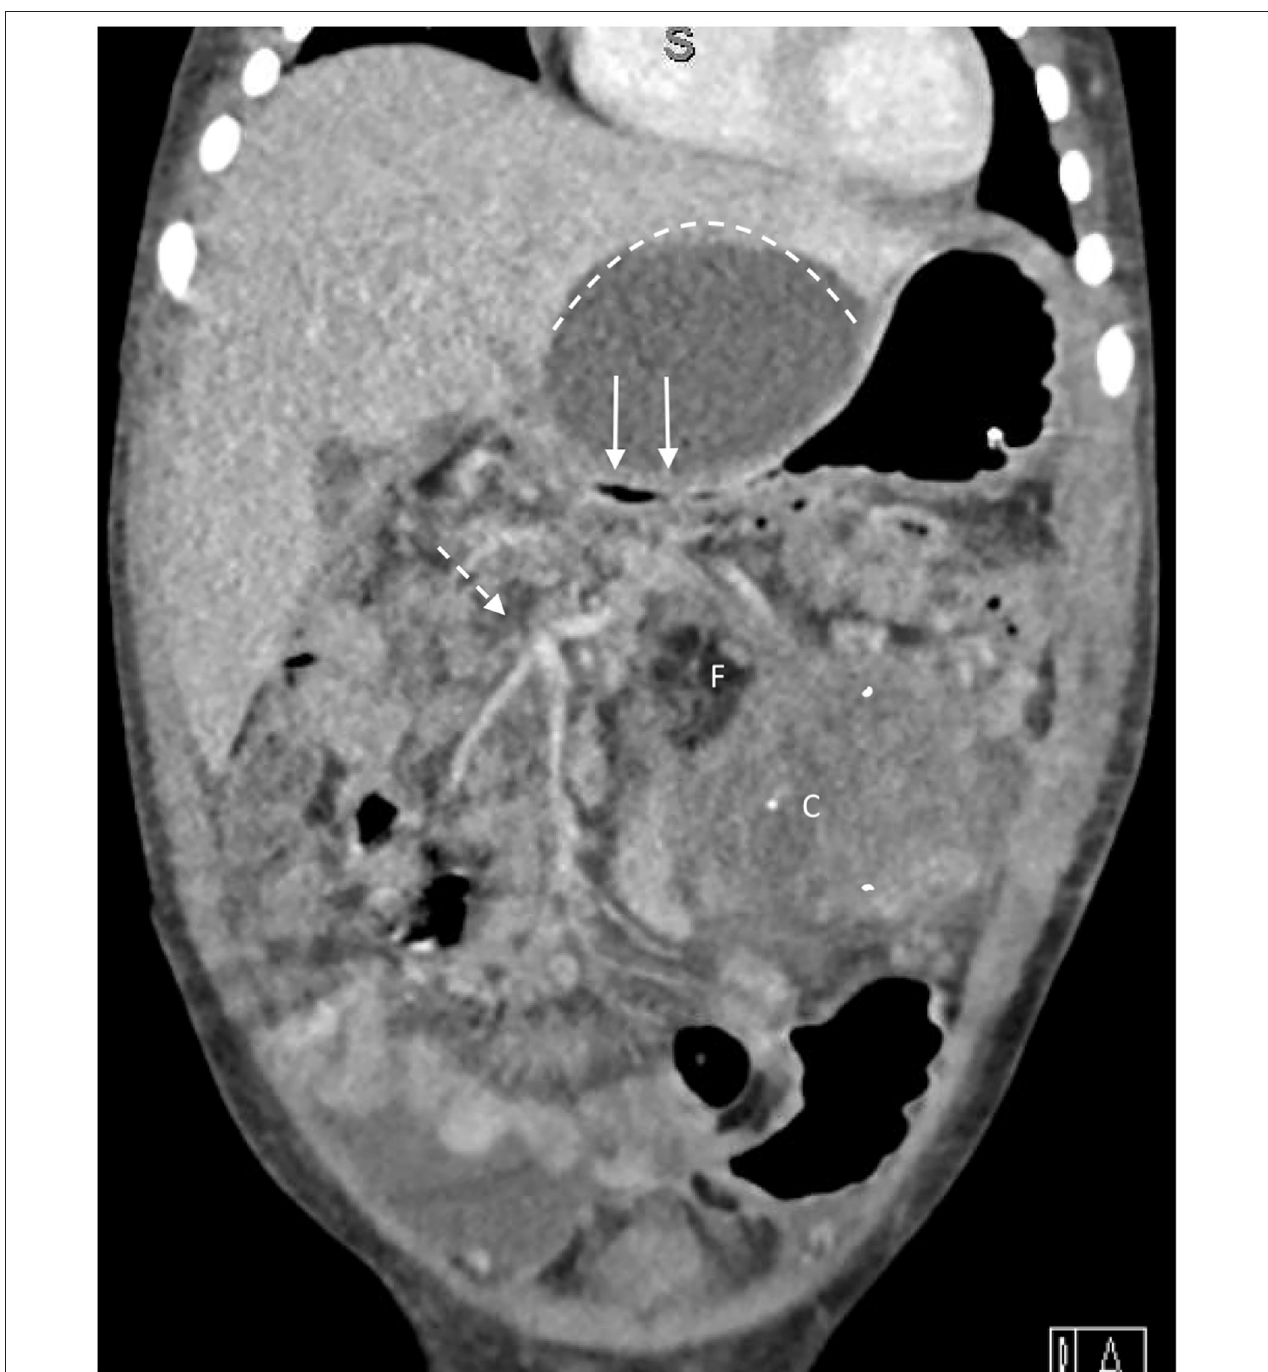
FIGURE 2 | Coronal section of CT scan from Case 2 demonstrates superior limit of cystic component (dotted line) which is compressing duodenum causing gastric outlet obstruction (solid arrows). The tumor contains fat (F) and areas of calcification (C), and encases superior mesenteric artery branches to the transverse colon (dotted